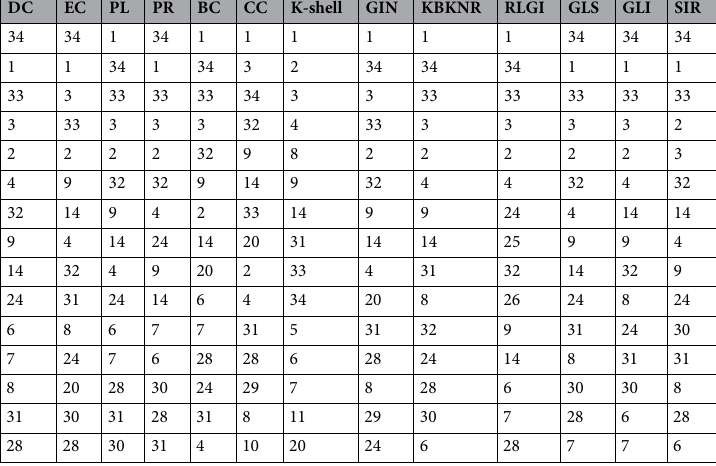
Table 7. Top-15 nodes in the Karate network obtained by different